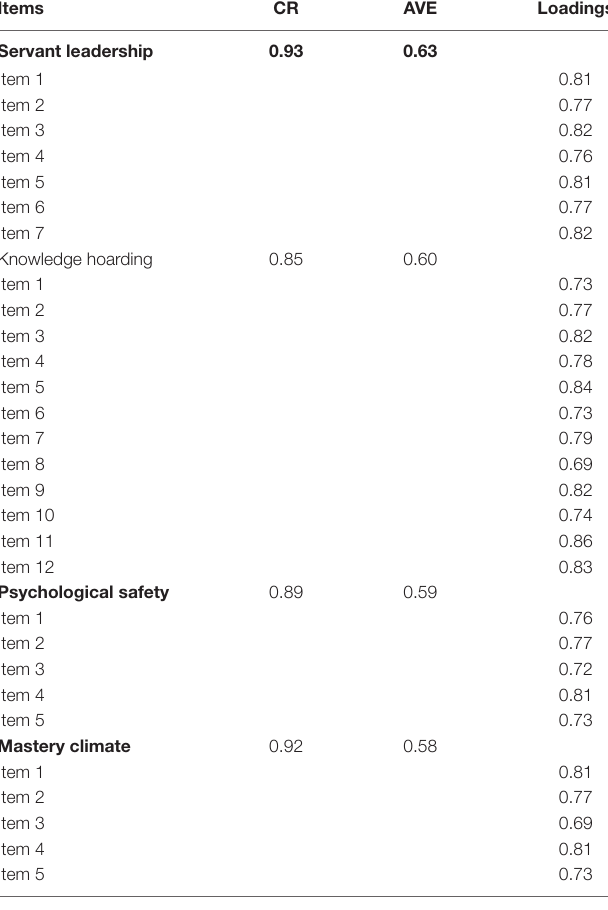
TABLE 2 | Factors loadings.